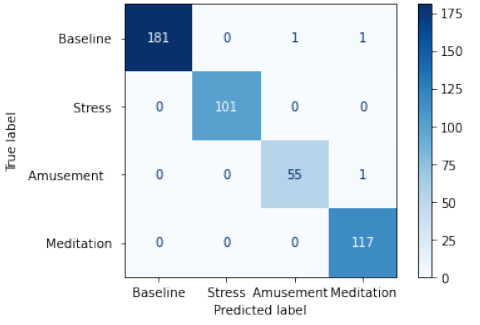
Figure 3. Confusion matrix for contrastive SSL model on the WESAD dataset.